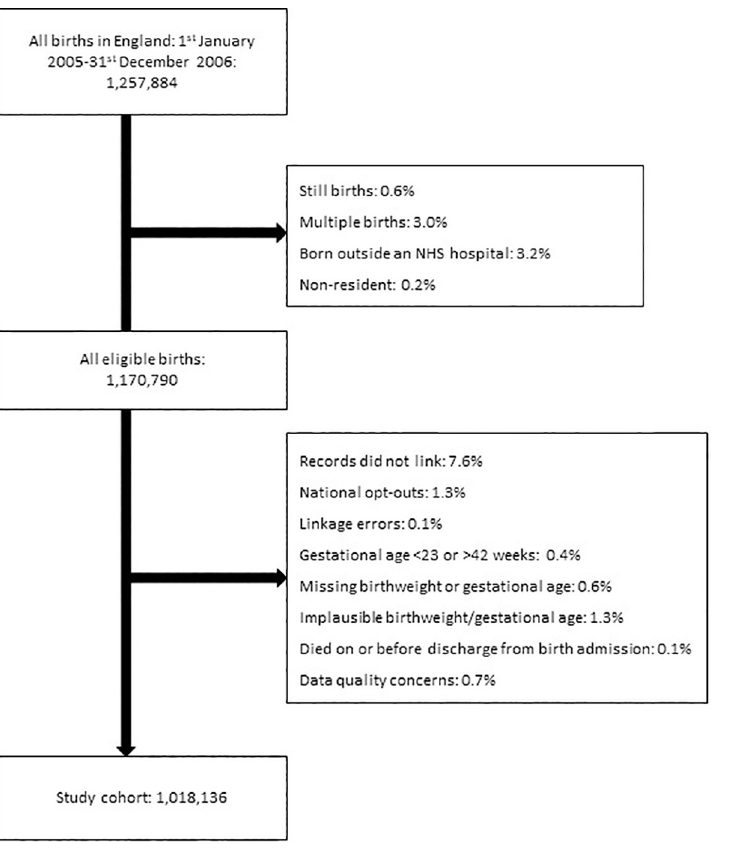
Fig 1. Flowchart of study cohort and